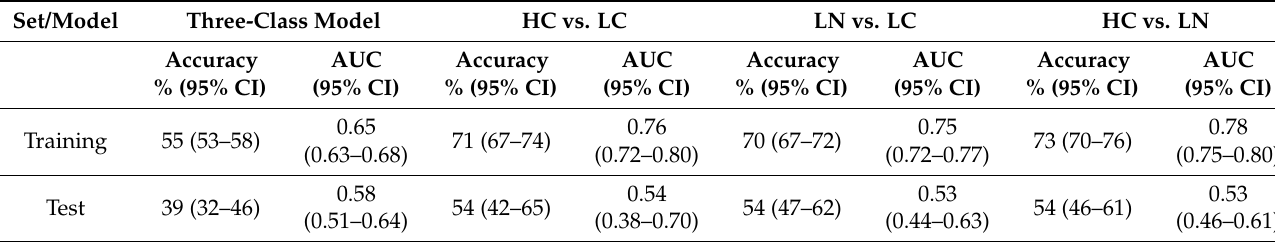
Table 2. Indices of the classification